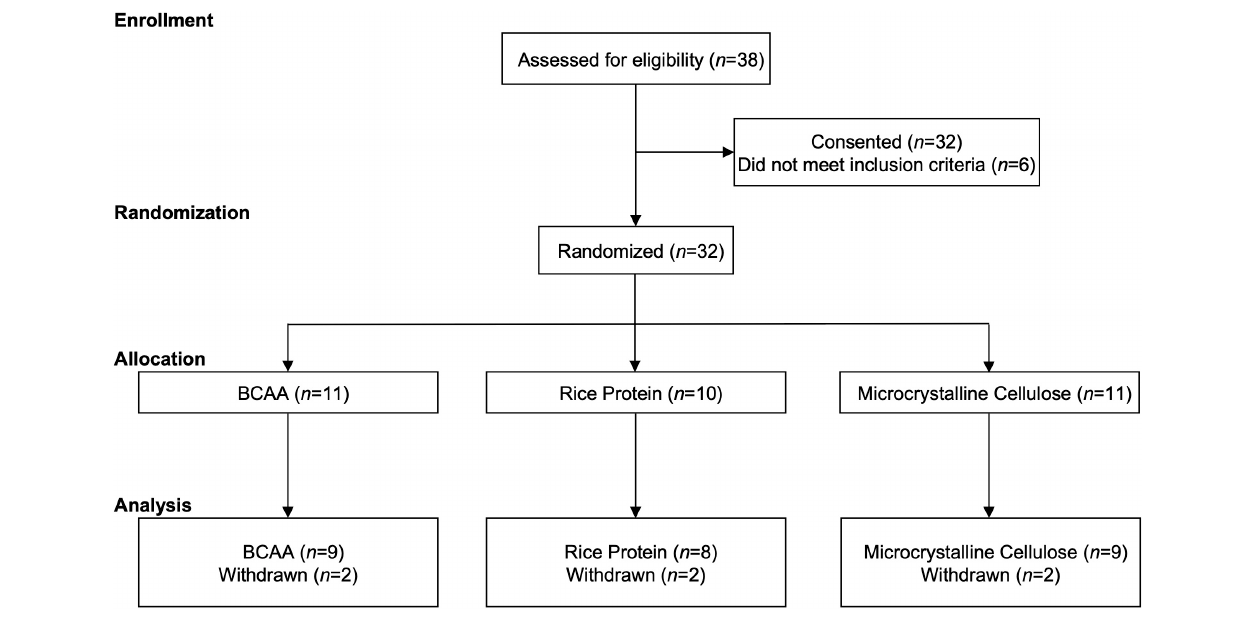
FIGURE 1 | CONSORT. Participant enrollment, randomization, allocation, and analysis following the CONSORT extension for randomized pilot and feasibility guidelines.